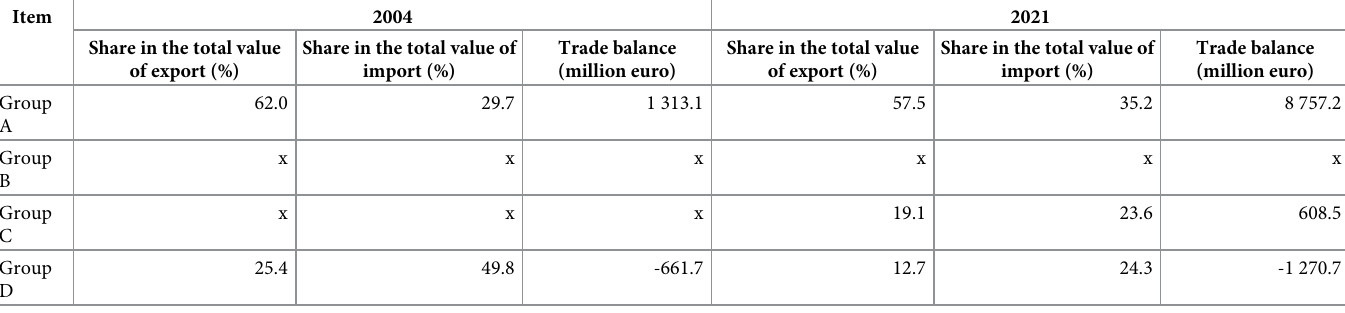
Table 6. Shares and trade balance of individual product groups resulting from Widodo’s matrix in the total value of agri-food trade between Poland and the other EU countries. Item Share in the total value of export